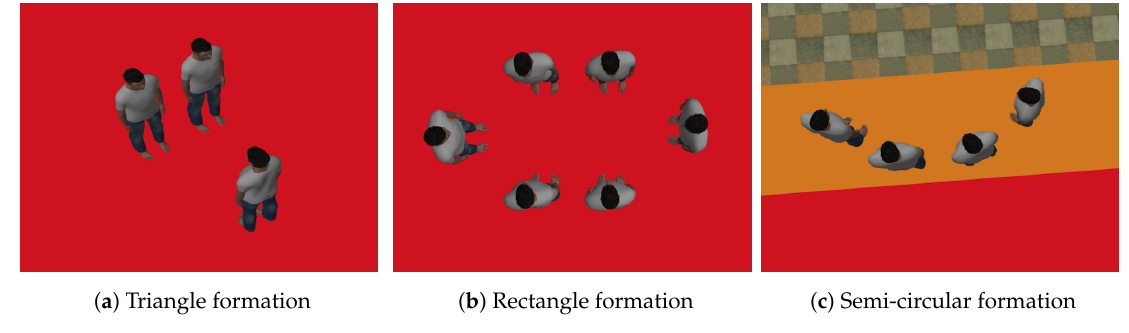
Figure 3. Constraint-based